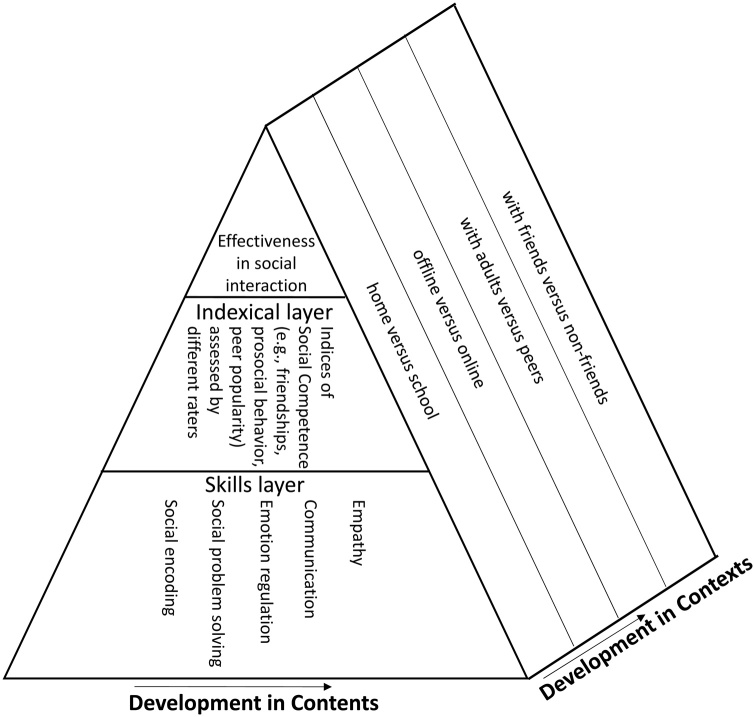
CID’s adaptation from Rose-Krasnor’s model of social competence (Rose‐Krasnor, 1997; Rose-Krasnor and Denham, 2009), adding a developmental perspective.